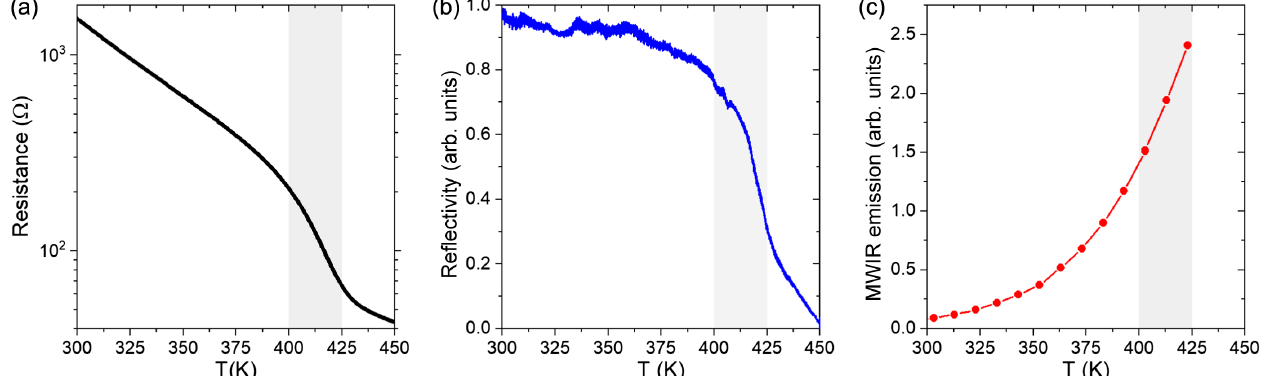
FIG. 1. Equilibrium properties of V 3 O 5 . (a) The resistance vs temperature [R ð T Þ ] and (b) the reflectivity vs temperature [Ref ð T Þ ] curves clearly show an IMT around 415 K (gray area). No thermal hysteresis can be observed in either curve, indicating a second-order phase transition. (c) Infrared (MWIR) emission vs temperature showing steady monotonic increase. No anomalous behavior in the vicinity of the IMT can be observed in the IR